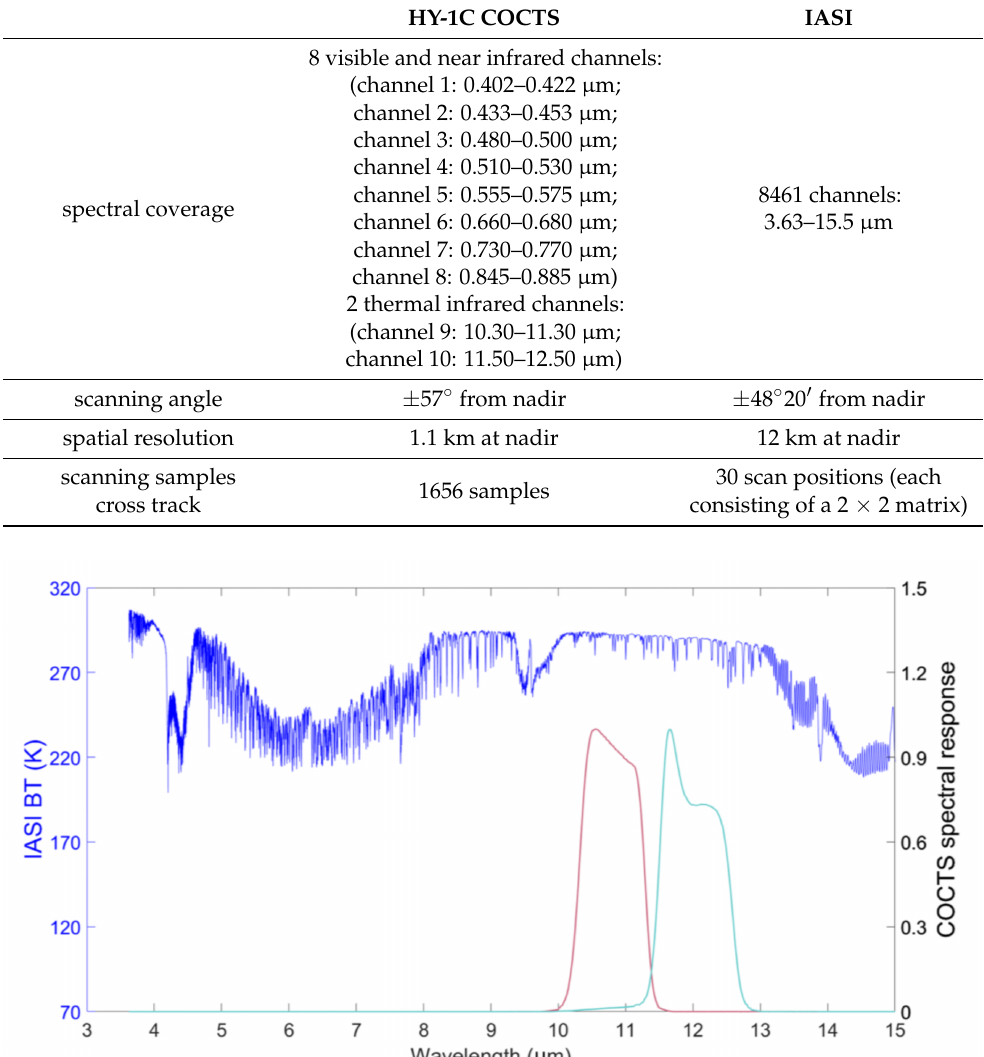
Table 1. The instrument characteristics of the Haiyang-1C (HY-1C) Chinese Ocean Color and Tem- perature Scanner (COCTS) and Infrared Atmospheric Sounding Interferometer (IASI).